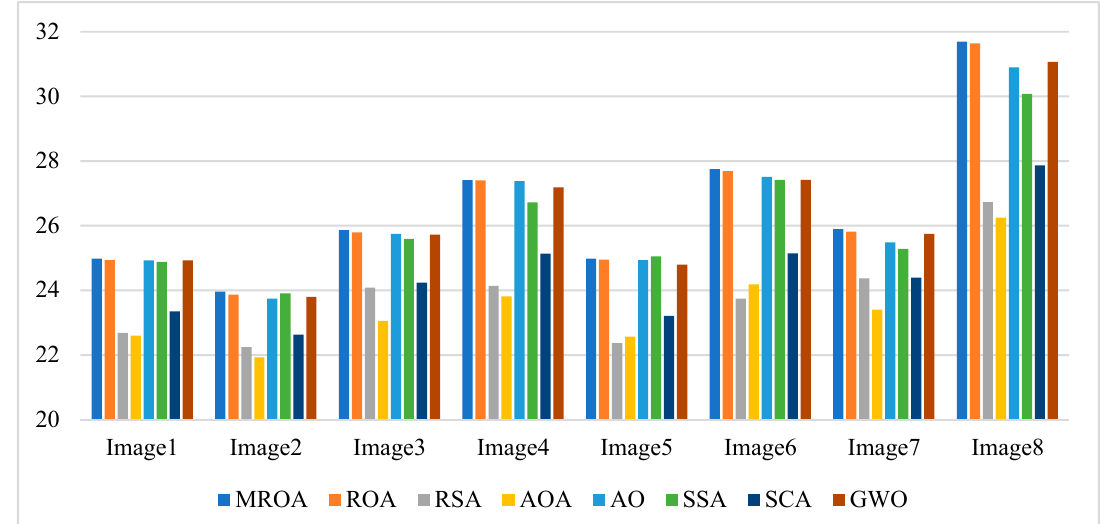
Figure 11. Average PSNR values obtained by the algorithms over all images.